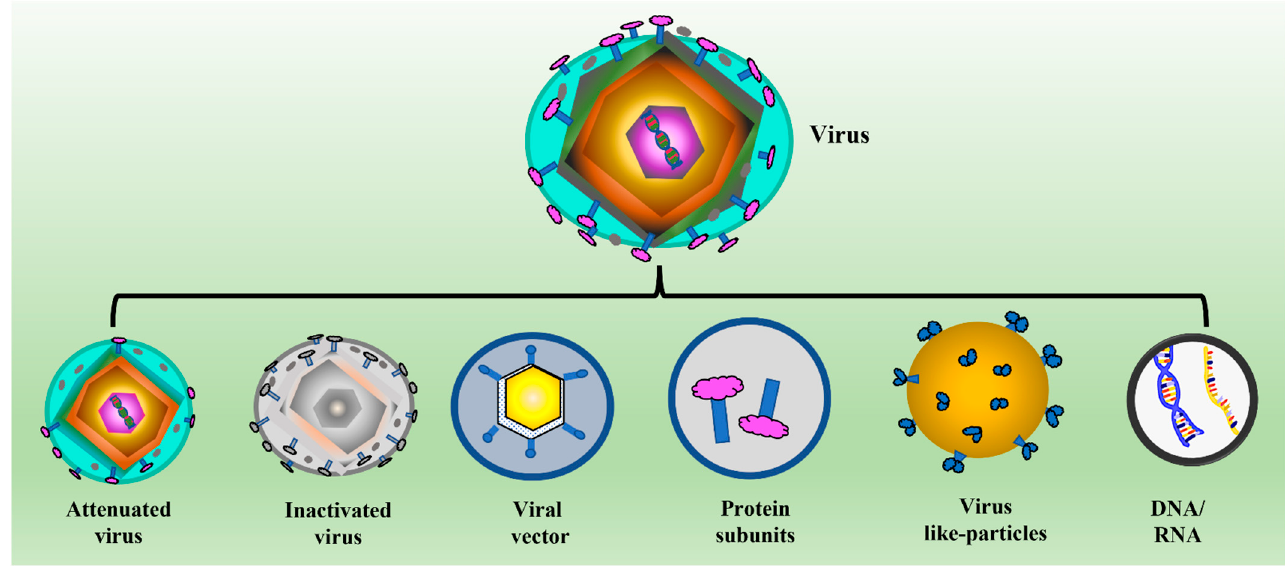
Figure 1. Schematic showing the different strategies of anti-viral vaccine development. The figure shows both conventional (attenuated and killed virus) and newer methods of vaccine development (including subunit, nucleic acid, and VLP-based vaccines).